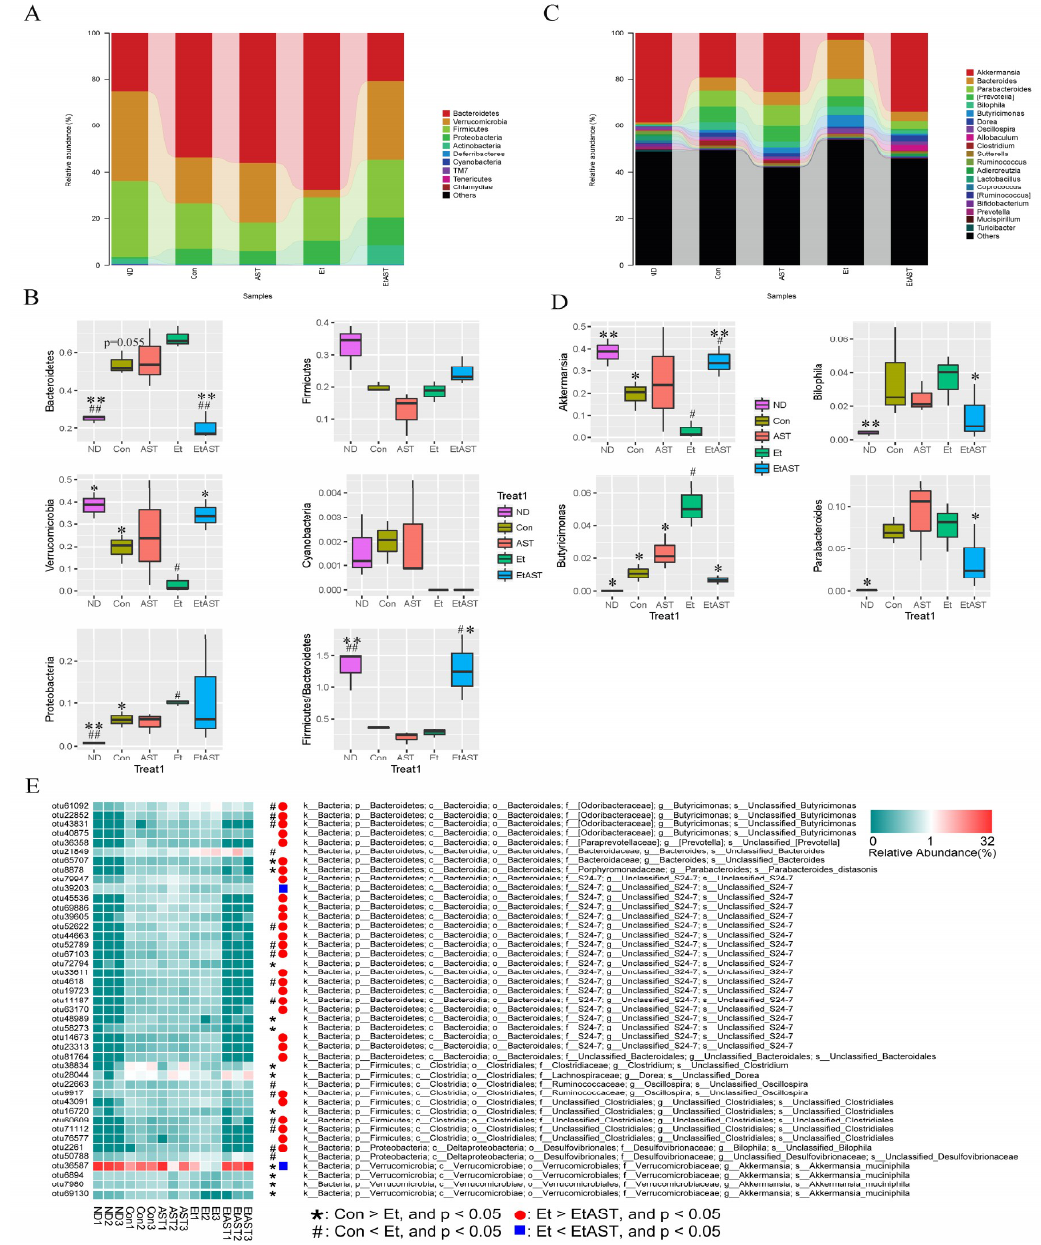
Figure 4. Bacterial community analysis and comparison. The composition and abundance distributions of each group at the phylum ( A ) and genus ( C ) levels were shown using QIIME software. At the phylum ( B ) and genus ( D ) levels, pairwise comparisons, conducted to determine the sequence amounts between two groups, were presented as pair-wise comparisons using Metastats analysis. # represents p < 0.05 and ## represents p < 0.01 compared with the Con group; * represents p < 0.05 and ** represents p < 0.01 compared with the Et group. A heat map of 43 operational taxonomic units (OTUs) which were altered in abundance by ethanol or astaxanthin is shown, based on the redundancy analysis (RDA) model. OTUs with a relative abundance greater than 0.1% in at least in one group were selected and used to analyze these differences. The red and green colors indicate the relative abundances of OTUs that were more or less abundant. The symbols represent the OTUs whose abundance were reduced and increased in the Et group relative to the Con group, while the circles in red and rectangles in blue represent the OTUs whose abundances were reduced and increased in the EtAST group relative to the Et group (E).